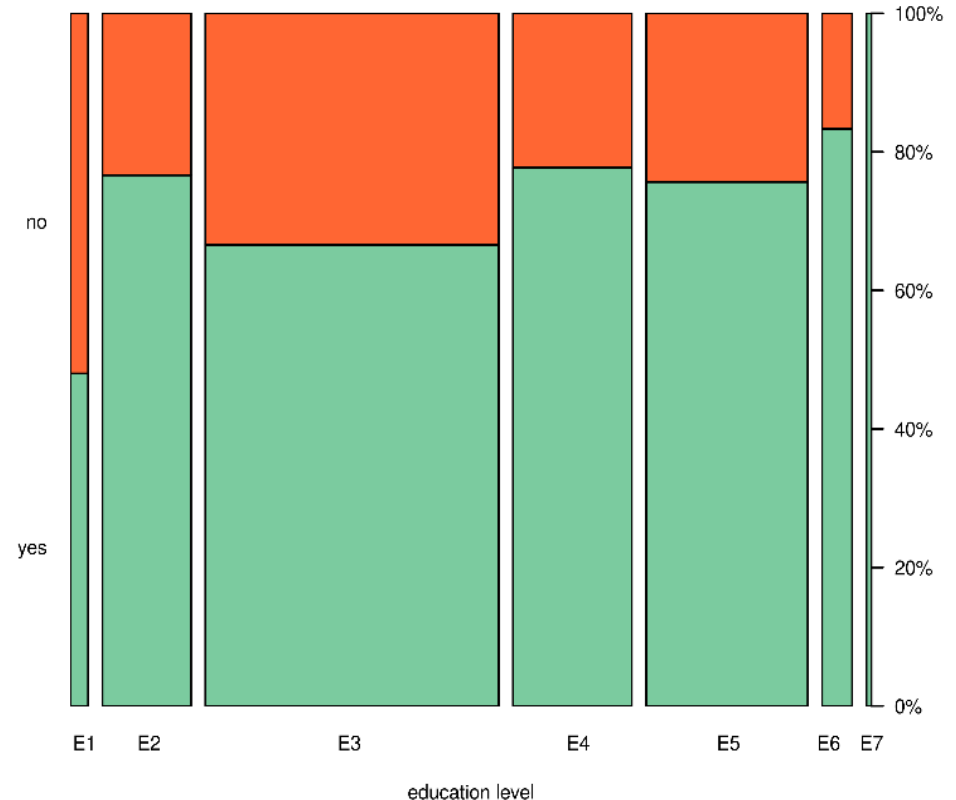
Figure 9. Propensity to track energy consumption by education level.